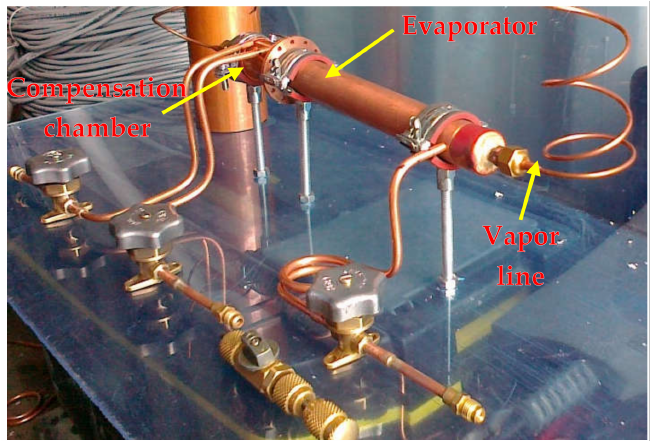
Figure 4. Photograph of the evaporator.